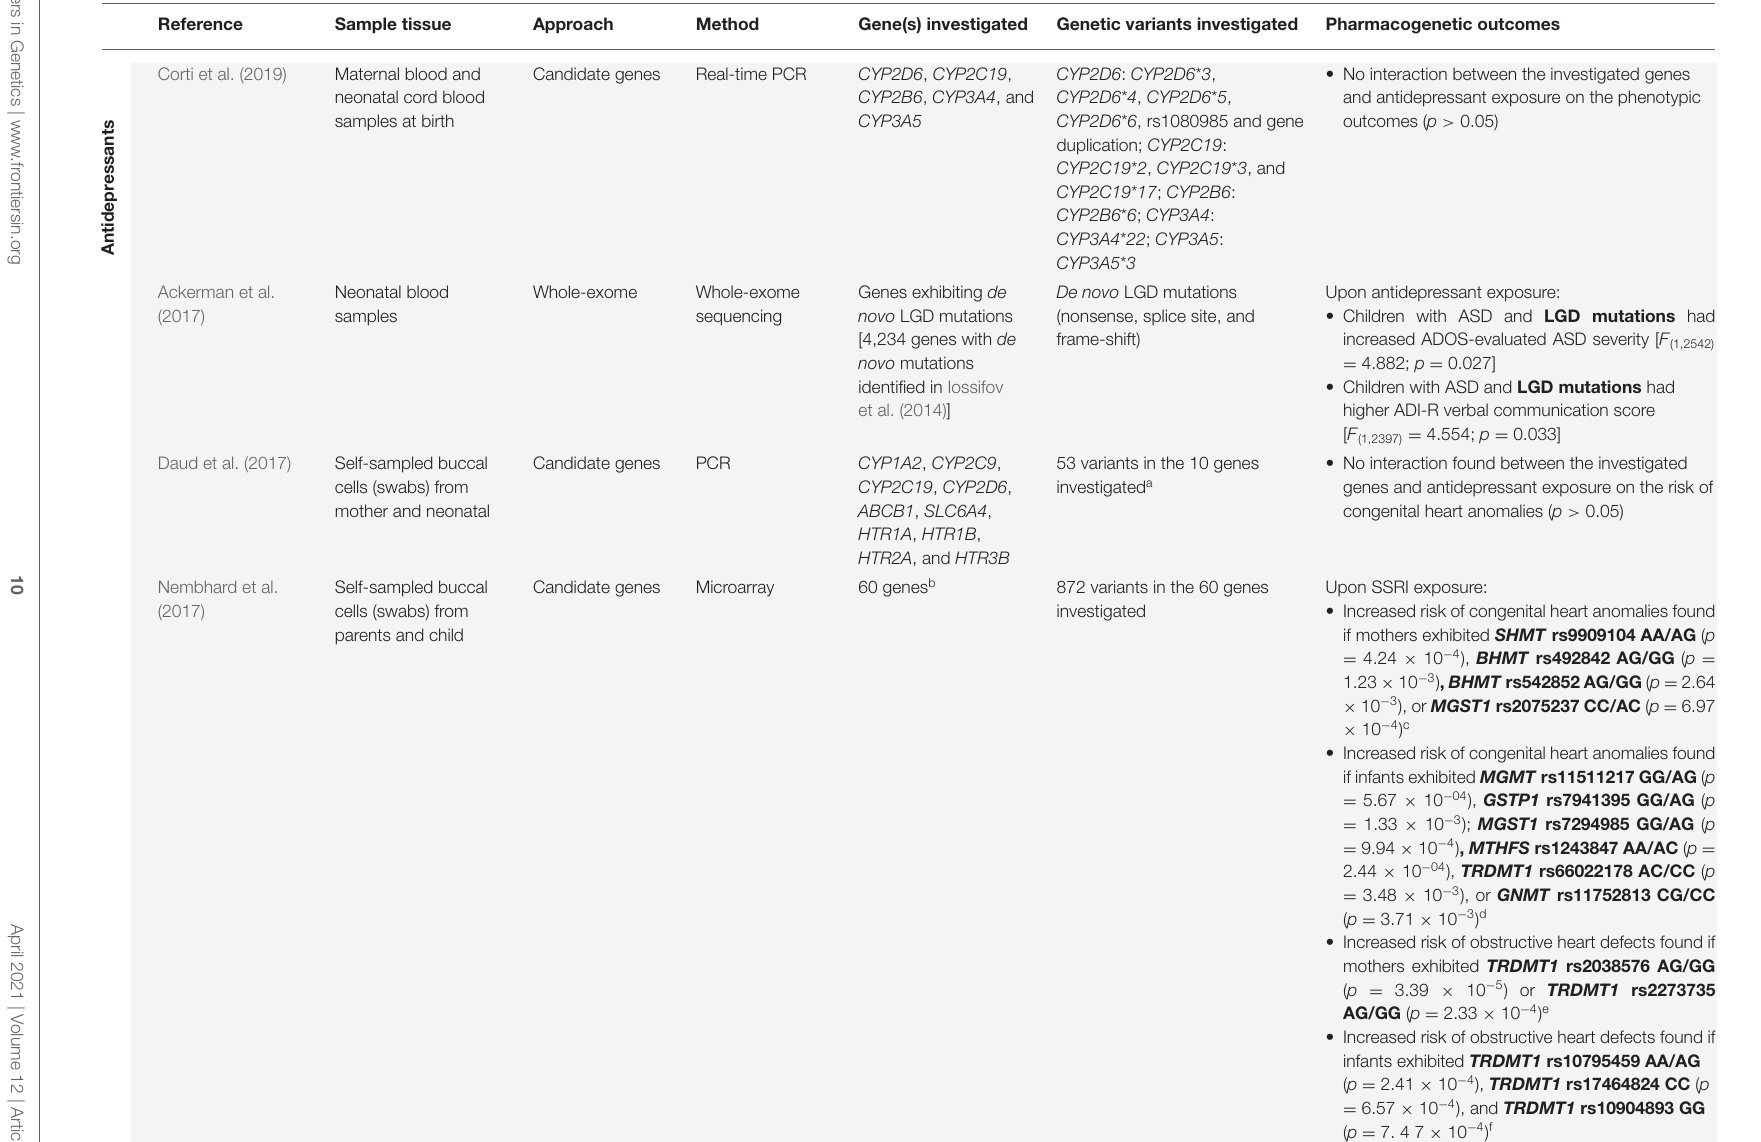
TABLE 2 | Overview of pharmacogenetic investigations and